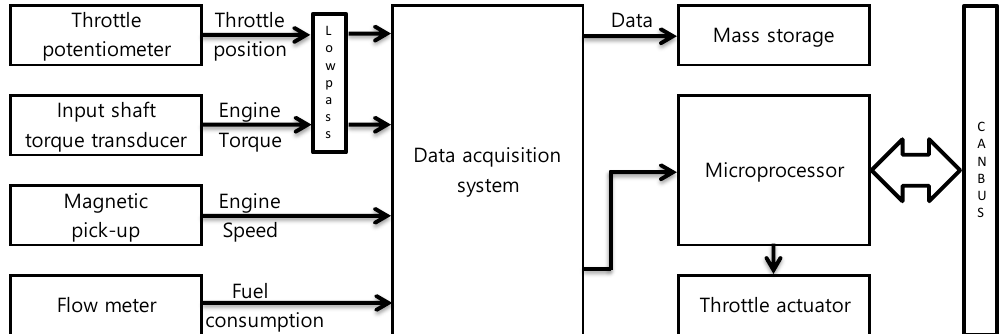
Figure 14. Schematic diagram of throttle control system.